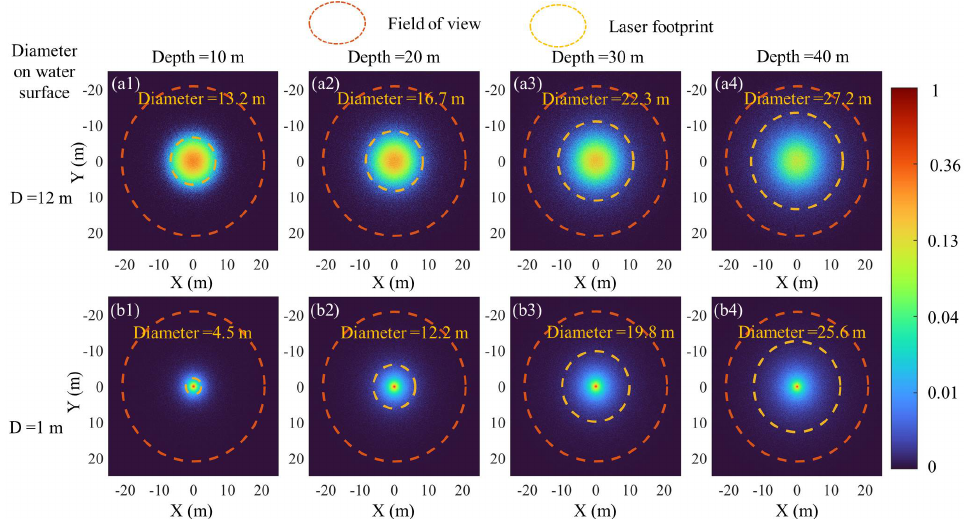
Figure 12. Normalized energy distributions at the seafloor with different laser footprints on the water surface and water depths. The yellow dotted circles contain 87.5% of the total laser energy (i.e., 2 sigma), and the red dotted circles represent a 42 m diameter of FOV on the water surface (i.e., ICESat-2 has an 83.5 µrad FOV and a flight altitude of approximately 500 km). In ( a1 – a4 ), the 12 m diameter of laser footprints on the water surface corresponds to ICESat-2 (which has an approximately 24 µrad laser divergence). In ( b1 – b4 ), the 1 m diameter is a typical laser footprint for ALB systems.